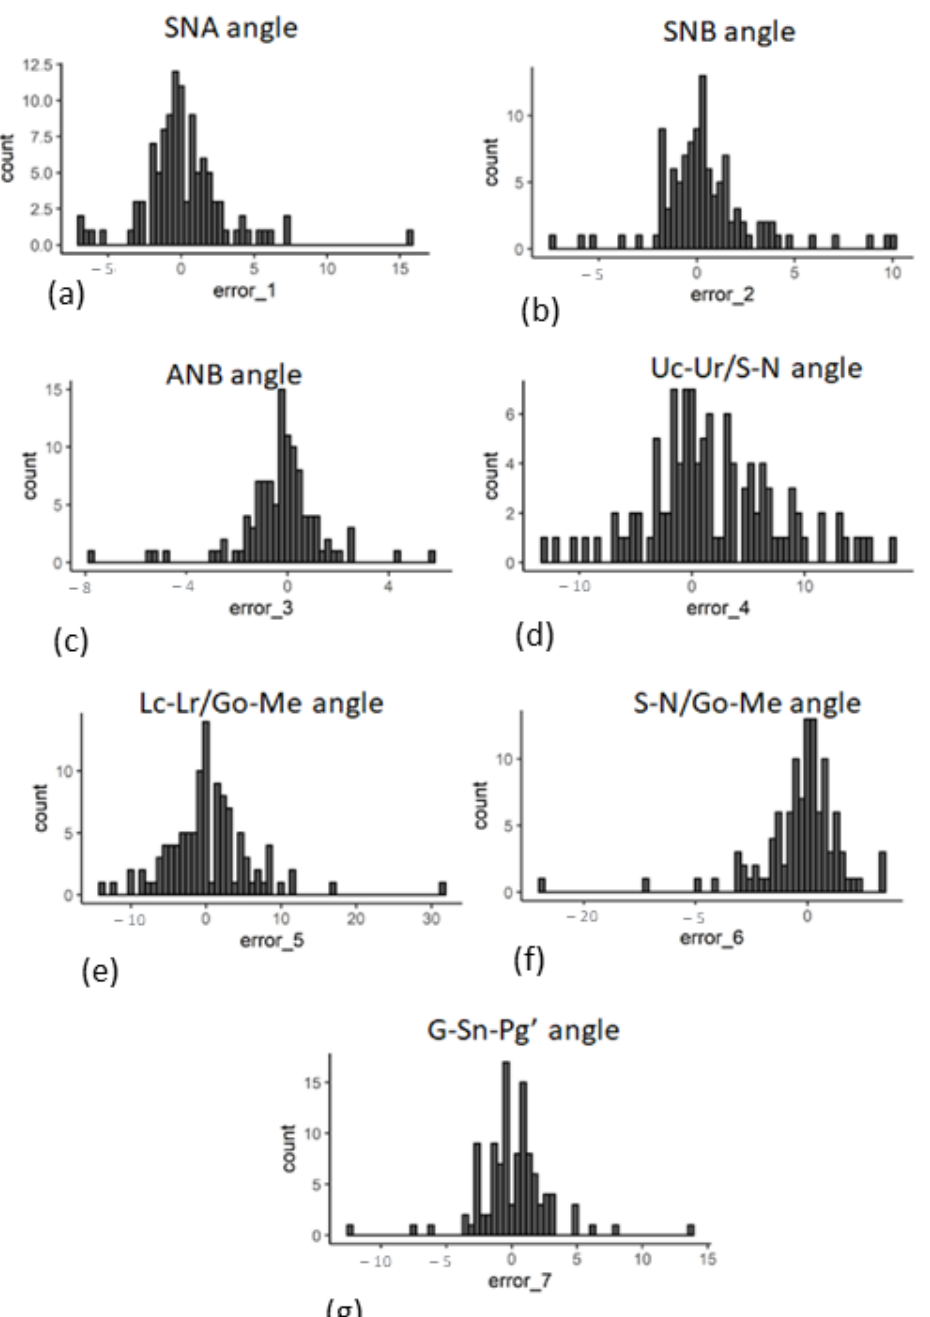
Figure 8. Error distribution in predicting the angular features. The distribution of the magnitude of the prediction error in degrees ( x -axis) is shown for ( a ) SNA, ( b ) SNB, ( c ) ANB, ( d ) Uc-UR/S-N, ( e ) Lc-Lr/Go-Me, ( f ) S-N/Go-Me, and ( g ) G-Sn-Pg’ angle.